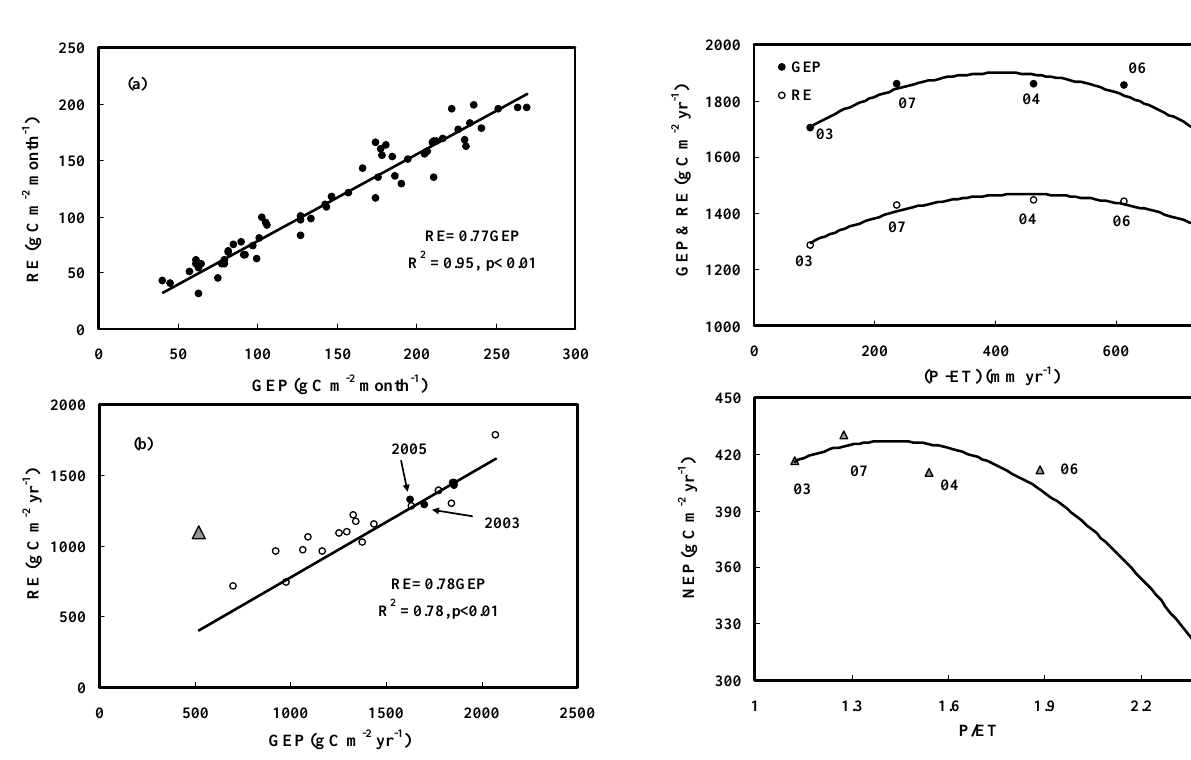
Fig. 7. The relationships (a) between yearly gross ecosystem photo- synthesis (GEP), ecosystem respiration (RE) and water balance ( P - ET), and (b) between yearly net ecosystem production (NEP) and water balance index ( P /ET) during 2003 to 2007 at Qianyanzhou site. Least-squares quadratic regressions were given by the solid line, and (a) GEP: R 2 = 0 . 94, p < 0 . 01 and RE: R 2 = 0 . 96, p < 0 . 01, and (b) R 2 = 0 . 96, p < 0 . 01.